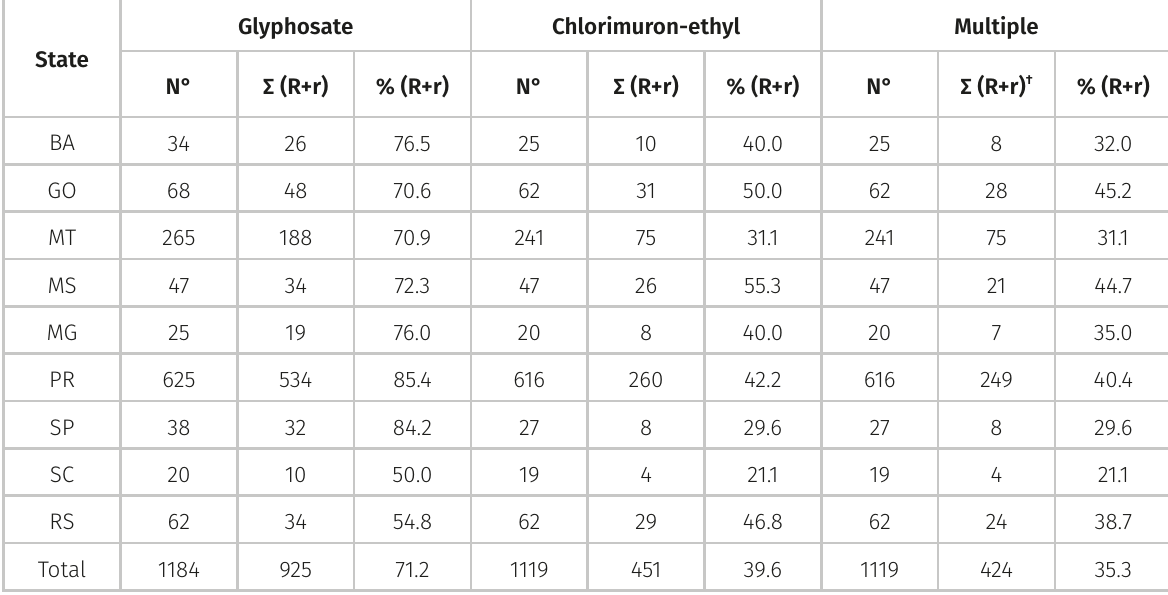
Table IV. Number (N°) and frequency (%) of Conyza spp. populations resistant (R) or moderately resistant (r) to glyphosate and chlorimuron-ethyl by state sampled in 2014, 2015, 2016, 2017, and 2018.